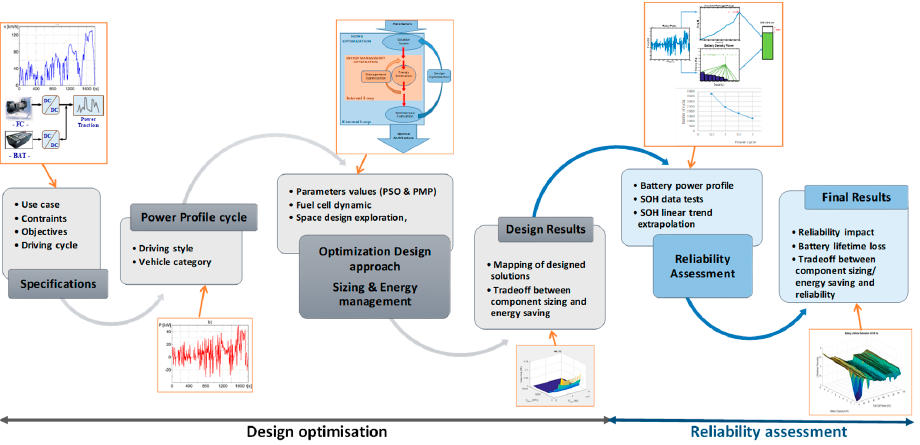
Figure 9. Reliability process integration.